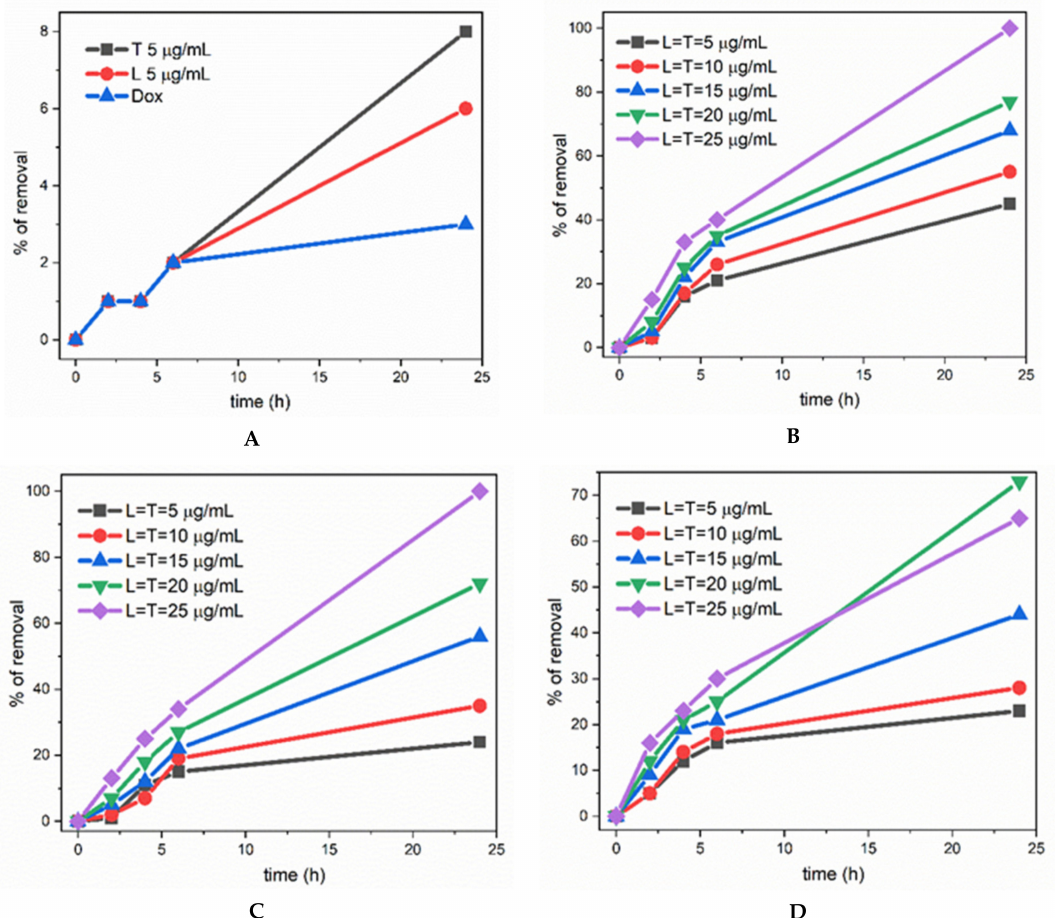
Figure 4. Percentage of removal of doxorubicin at pH 7: ( A ) blue, plain doxorubicin; red, in the presence of laccase; black, in the presence of TEMPO; ( B – D ) with the simultaneous presence of the laccase enzyme (L) and TEMPO (T) free radical. Starting doxorubicin concentrations: ( A ) 75 mg/mL;